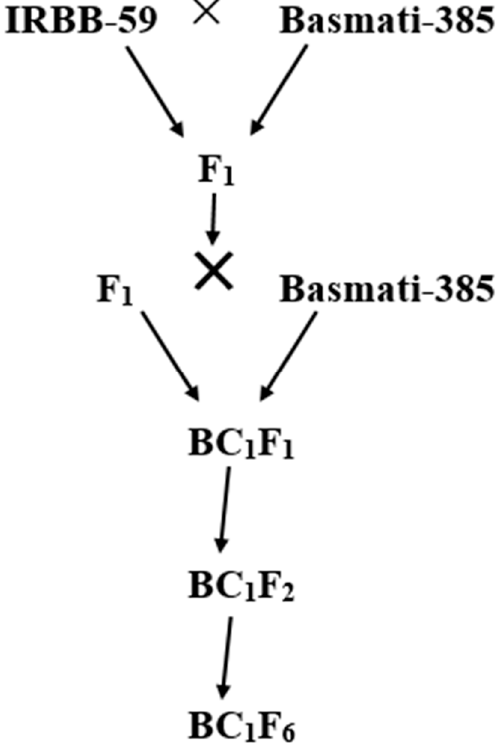
Figure 10. Breeding scheme for developing pyramided lines.